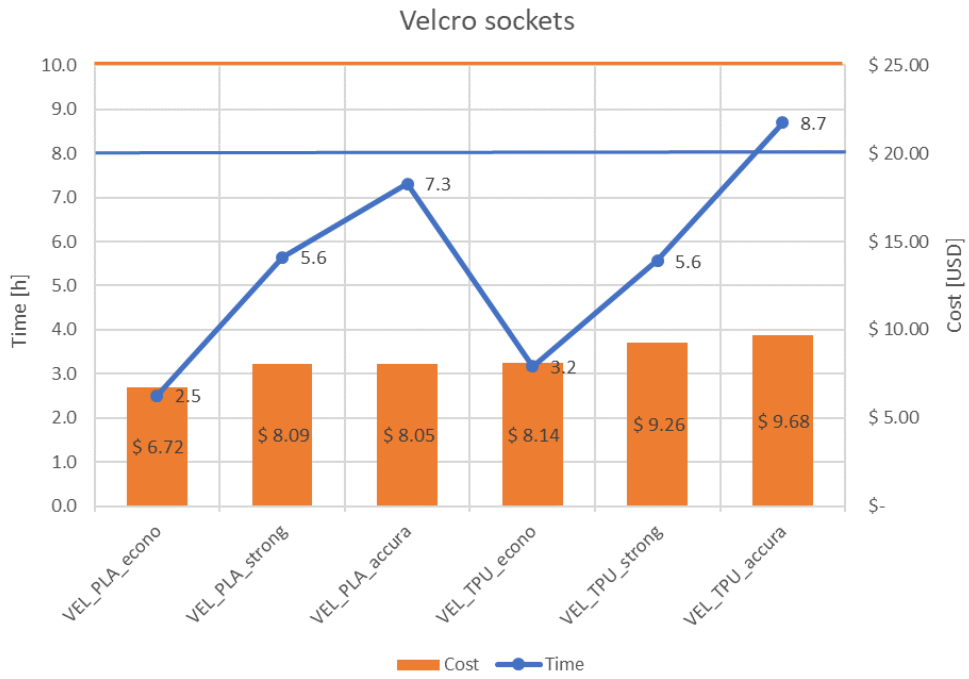
Figure 12. Cost and time of manufacturing — VEL socket.